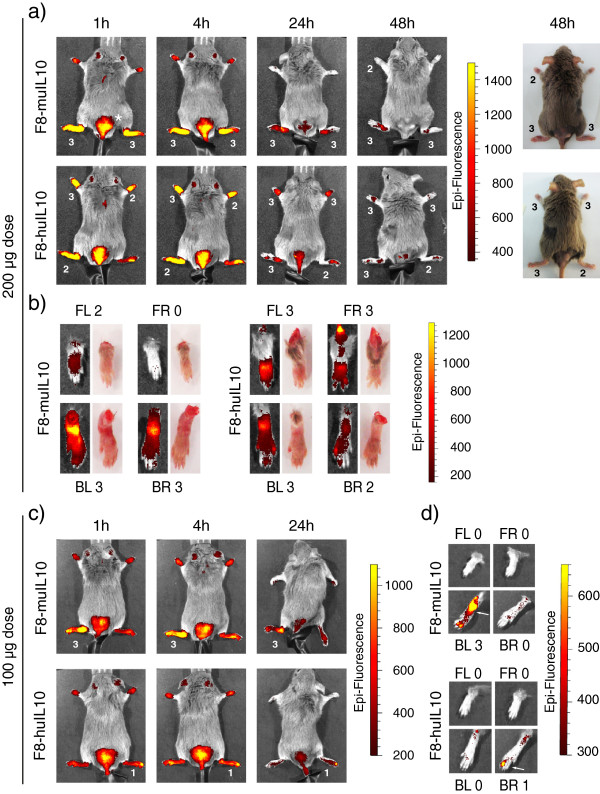
In vivo near-infrared fluorescence imaging of F8-IL10 fusion proteins in mice with collagen-induced arthritis. Arthritic mice (n = 1) were injected intravenously with 200 or 100 μg F8-muIL10 or F8-huIL10 labeled with IRDye 750. (a) Mice injected with 200 μg of fusion protein were imaged 1, 4, 24 and 48 hours after injection. (b) After 48 hours mice were sacrificed and individual paws were imaged. In addition, photographs of paws are shown to illustrate the paw swelling. (c) Mice injected with 100 μg fusion protein were imaged 1, 4, and 24 hours after injection. (d) After 24 hours mice were sacrificed and individual paws were imaged. Indicated numbers represent the score of the according paw: 1, one toe inflamed and swollen; 2, more than one toe, but not entire paw, inflamed and swollen or mild swelling of entire paw; 3, entire paw inflamed and swollen. FL, front left; FR, front right; BL, back left; BR, back right; plus the according score. *Site of immunization.